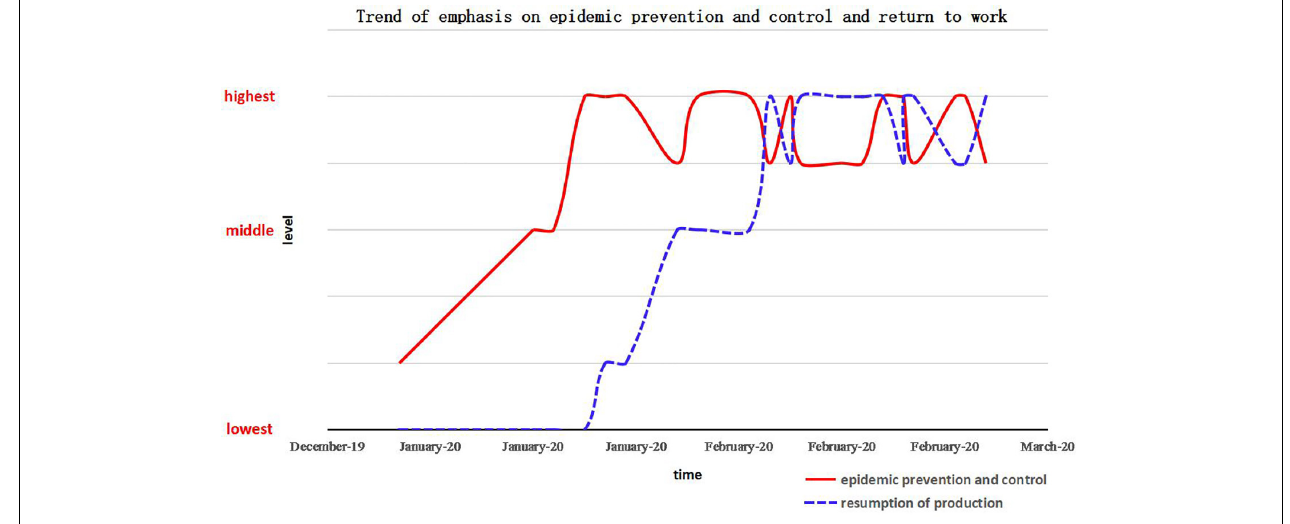
FIGURE 1 | Development trend of attention on epidemic prevention and control and on the resumption of work and production.